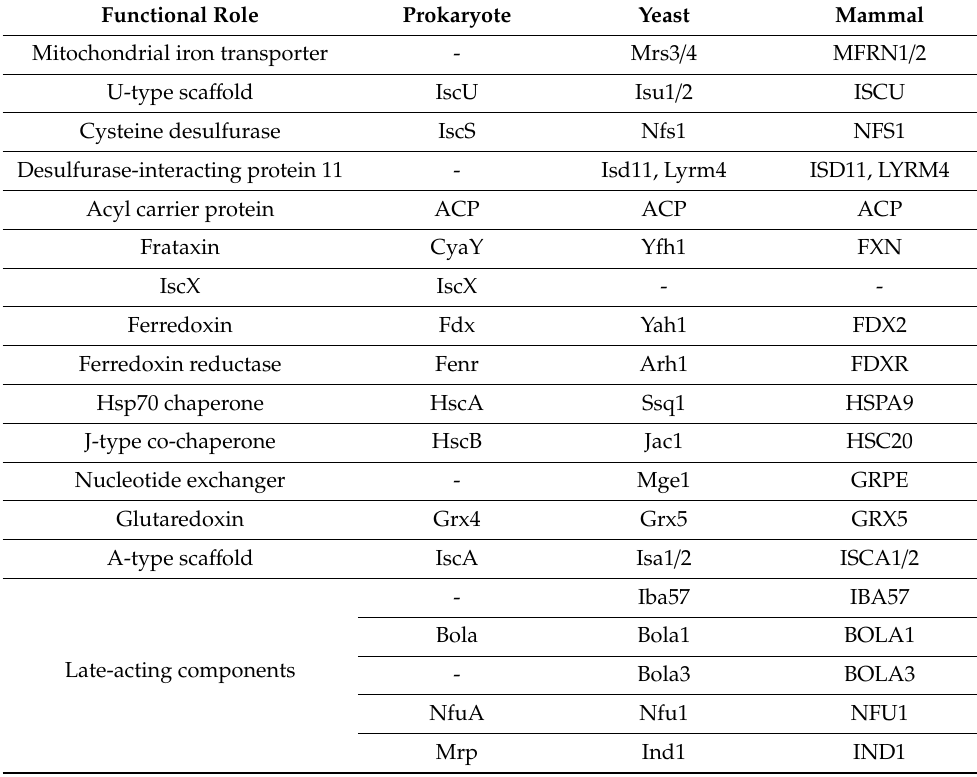
Table 1. Corresponding names of the components of the iron–sulfur cluster (ISC) machinery and accessory proteins in prokaryotes, yeast and